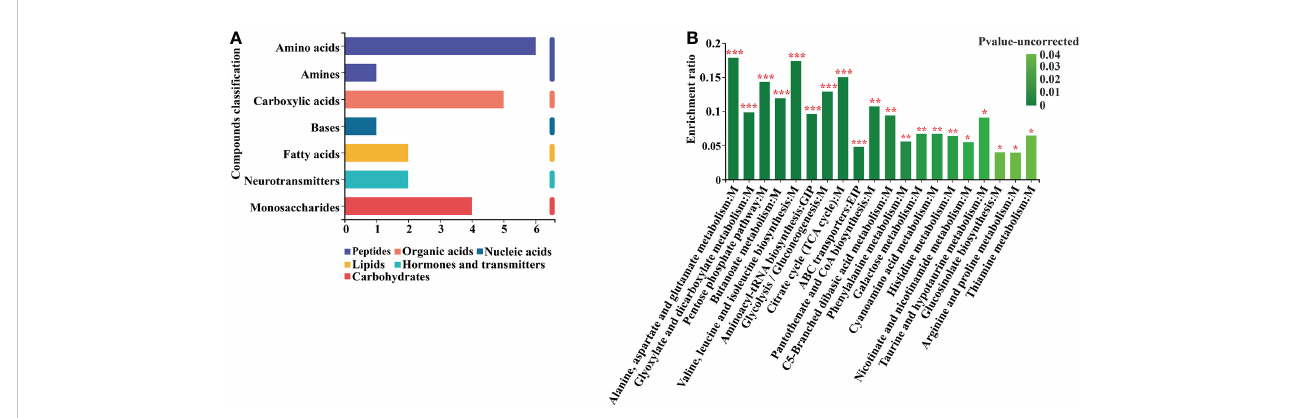
FIGURE 7 Differential metabolite KEGG analysis. (A) Annotated enrichment of differential metabolite KEGG compounds. (B) Analysis of differential metabolite importance. *, ** and *** indicates statistical signi fi cance at p < 0.05, p < 0.01 and p < 0.001, respectively (Student ’ s